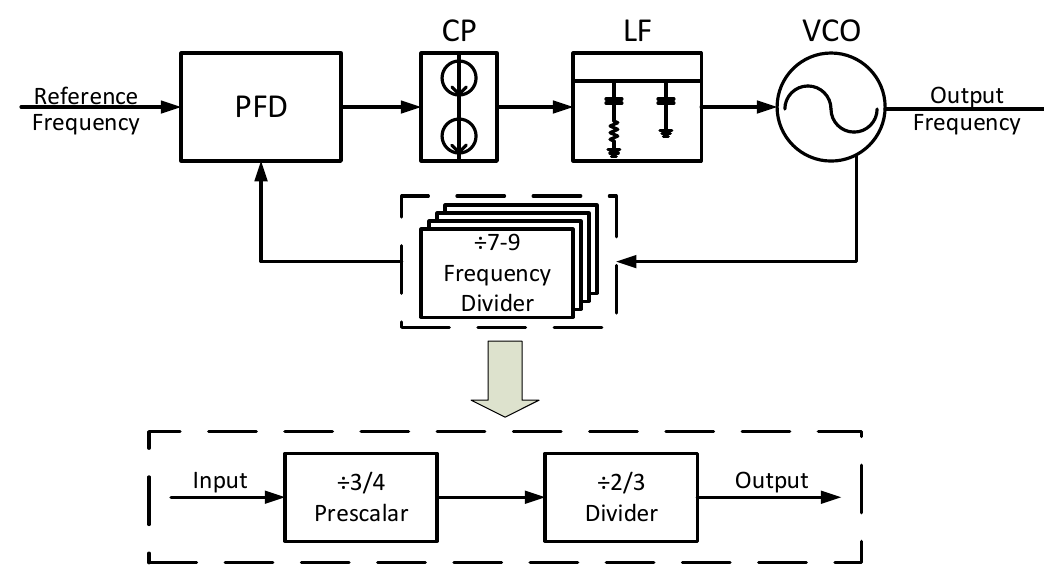
Figure 1. Block diagram of the proposed phase-locked-loop (PLL) synthesizer.